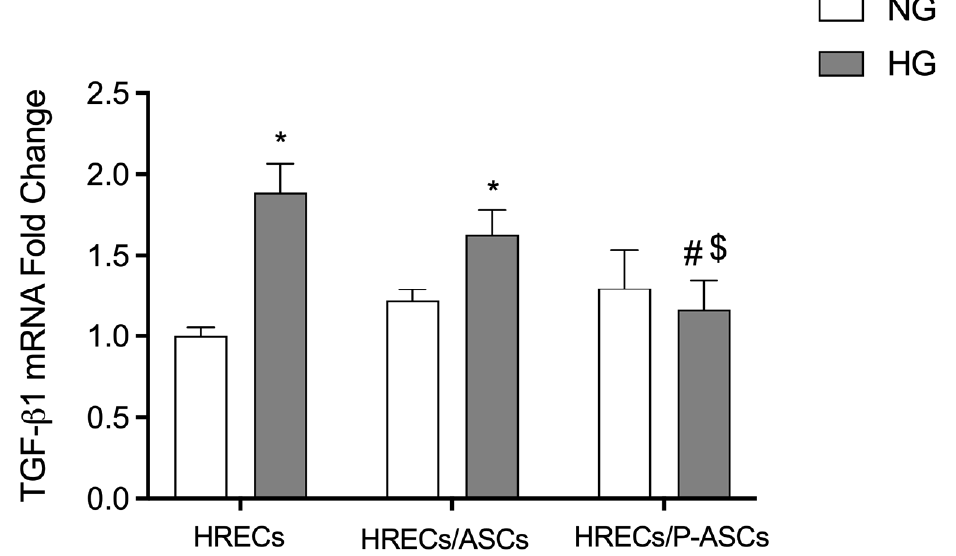
Figure 4. TGF- β 1 mRNA levels in cultures of human retinal endothelial cells (HRECs) alone and co-cultured with human adipose-derived mesenchymal stem cells (ASCs) or pericyte-like ASCs (P-ASCs). TGF- β 1 mRNA levels were measured in HRECs by qRT-PCR from samples that were cultured either in normal glucose (NG) or high glucose (HG) conditions. mRNA levels of each group were normalized to the housekeeping reference gene ribosomal 18S RNA. In the histograms, values are expressed as the fold change in those detected in HRECs cultured in NG conditions. A significant reduction in HG-induced increased TGF- β 1 mRNA levels can be found when HRECs were co-cultured with ASCs and, especially, P-ASCs. Each value represents mean ± SEM obtained from three independent experiments. * p < 0.05 vs. HRECs in NG; # p < 0.05 vs. HRECs in